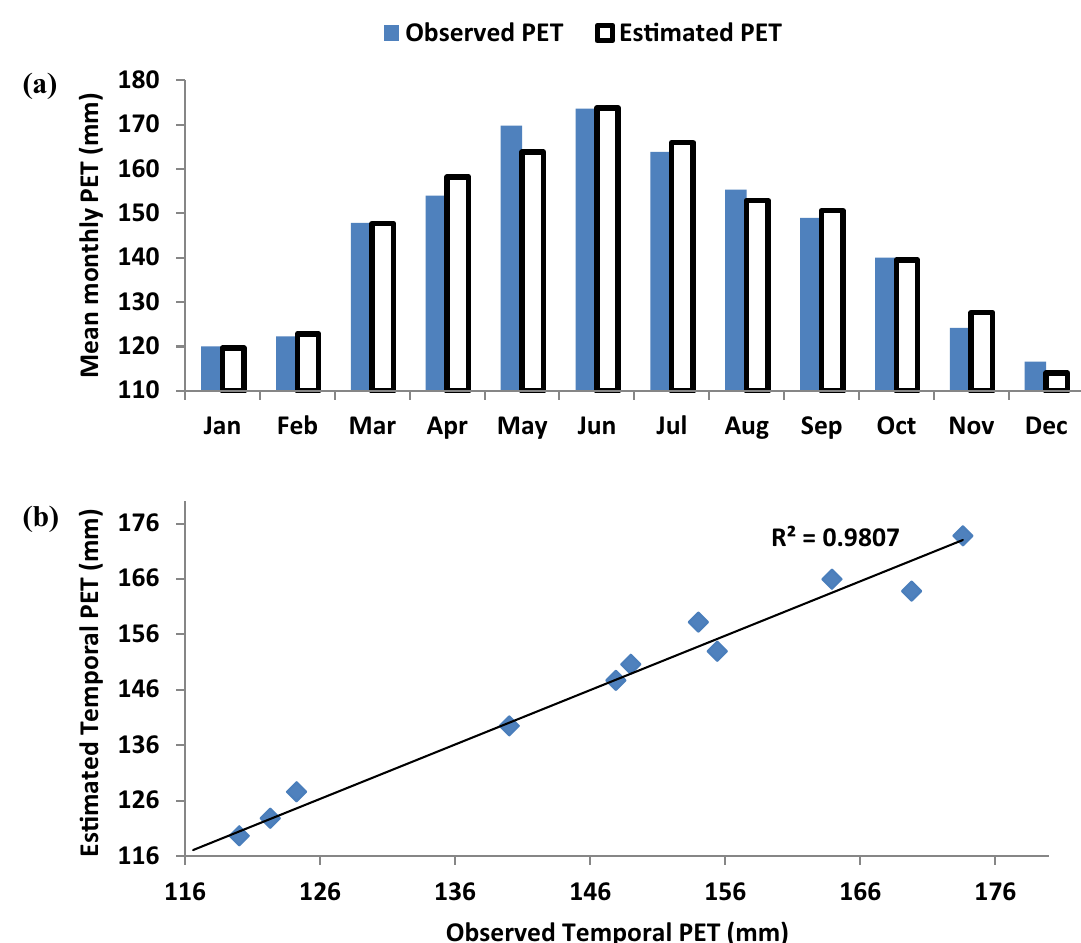
Fig. 7 Estimated and observed monthly time series of the PET a , and Comparisons between PET predicted by Landscape-climate predictors and that derived from the measured temperature time series